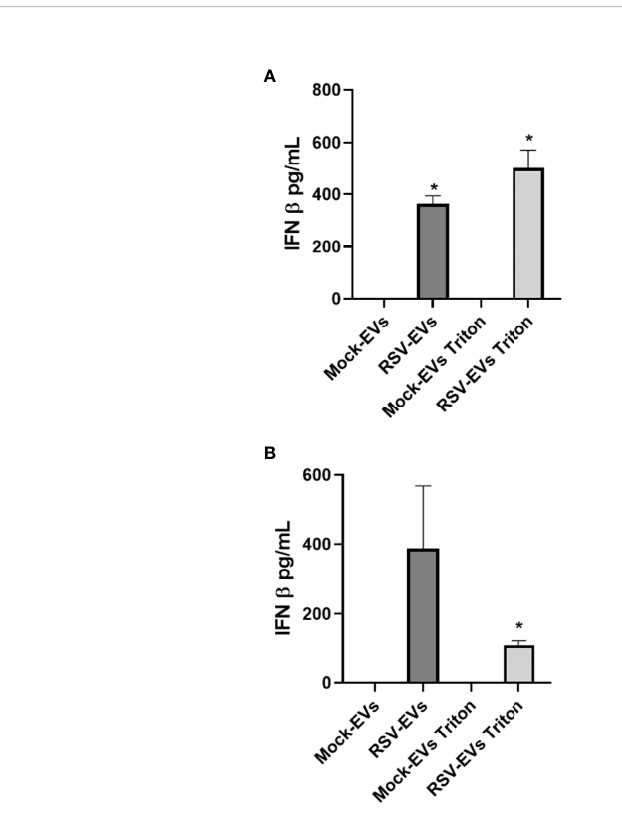
(ApoB) and cis-Golgi matrix protein GM130 (Figure 5A). EV